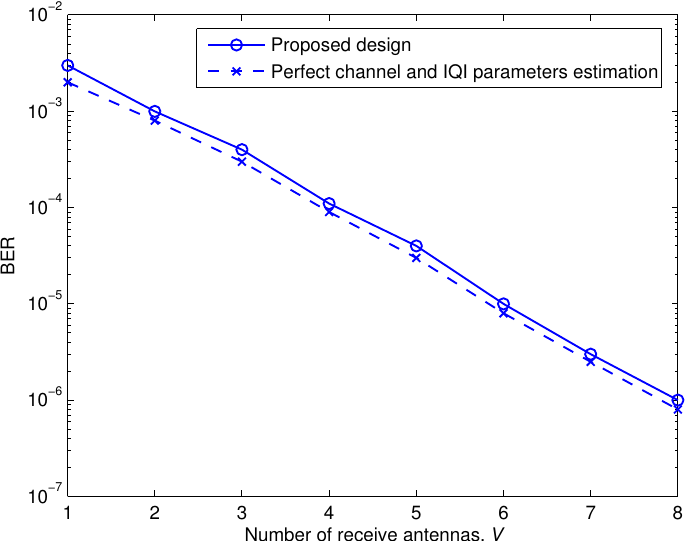
Figure 8. BER performance of the suggested strategy when there are multiple antennas at the destination, SNR = 4